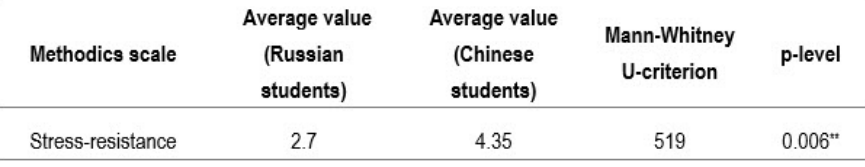
Results of determining the significance of differences in the level of stress resistance indices in Russian and Chinese students (n=80)